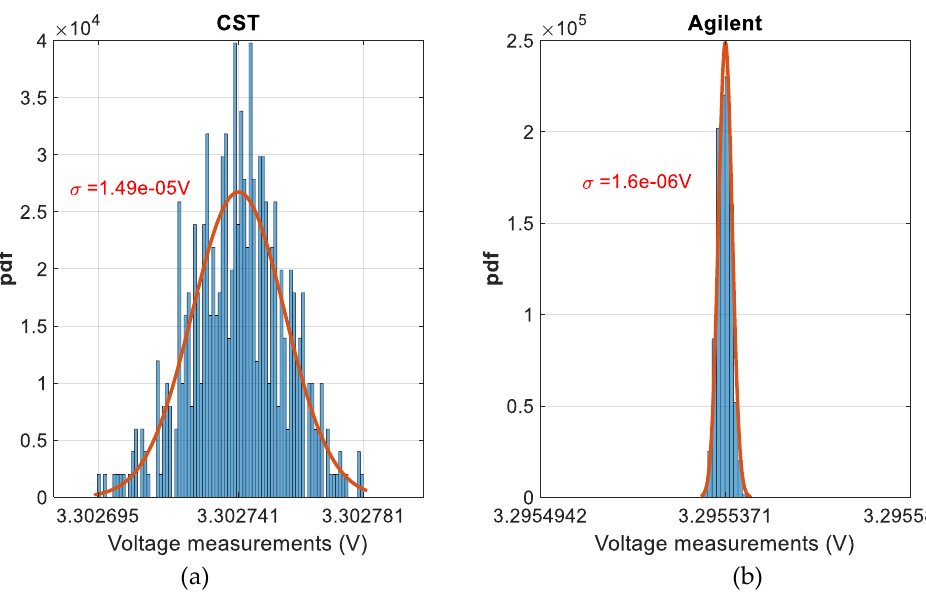
Figure 10. Pdf of 600 measurements carried out over a relaxed CA40 cell by: ( a ) our Cell Station Tester (CST); ( b ) an Agilent 34401A digital meter used as reference instrument. The mean values and standard deviations of the approximating Gaussian functions are shown on the diagrams.